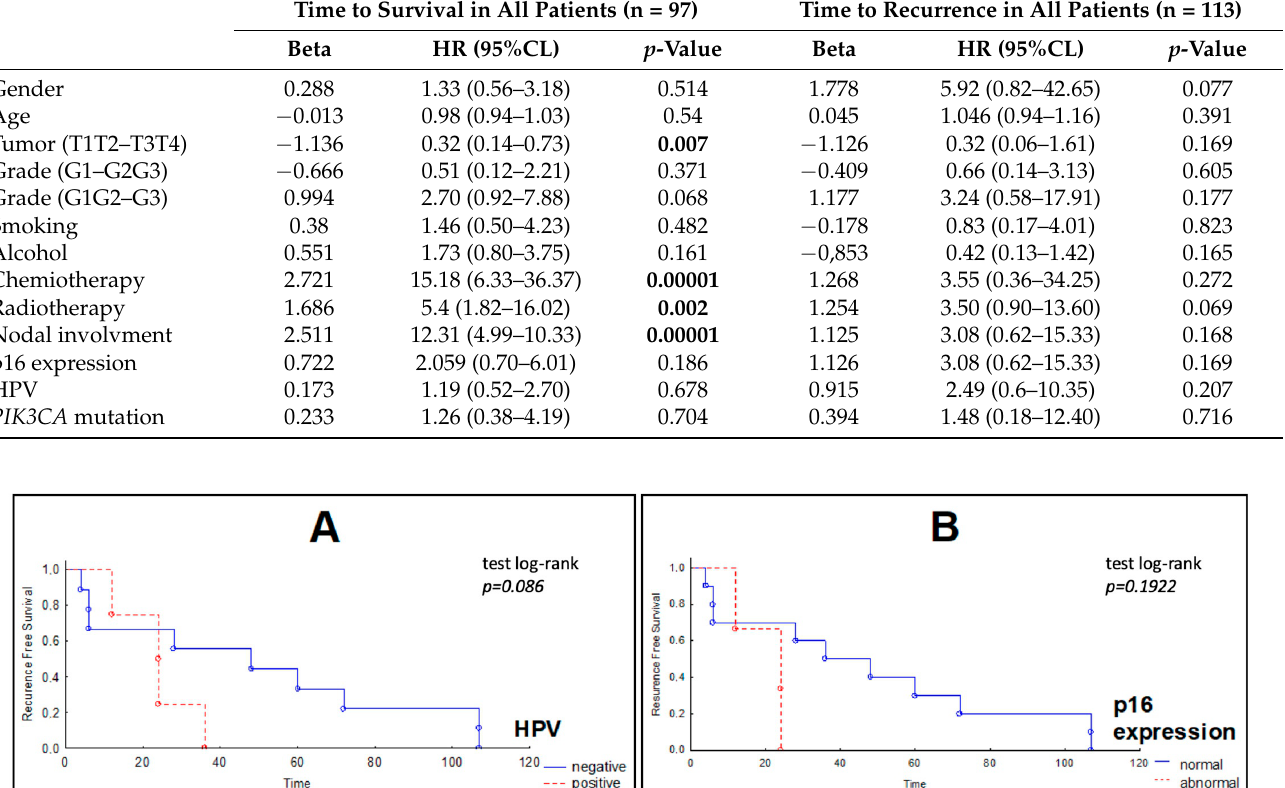
Table 3. Univariate Cox regression analysis of potential predictor variables ( p < 0.05 was bolded; abbreviations: HR—hazard ratio, CI—confidence intervals, HPV—human papilloma virus).